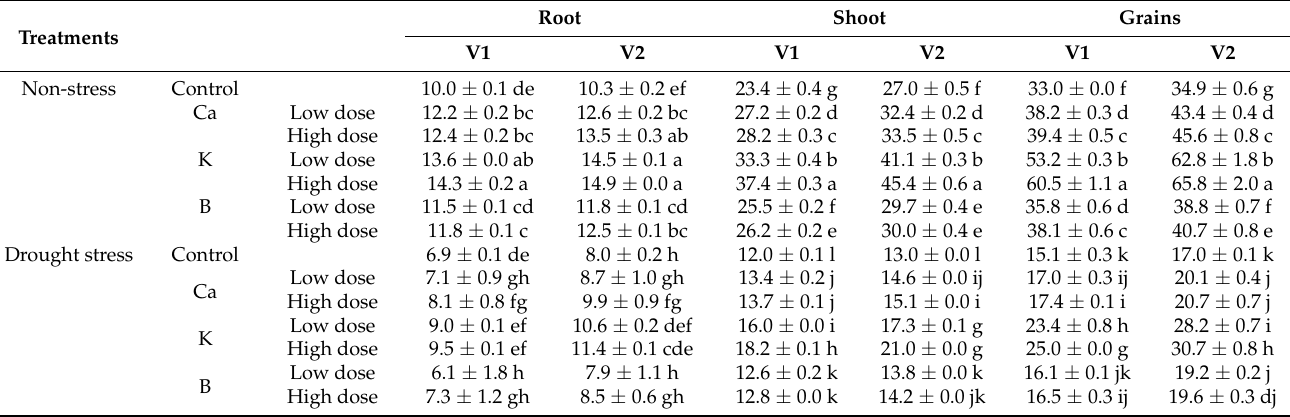
Table 3. Analysis of K content in the root, shoot, and grains of durum wheat. Different letters shows significant difference among the treatments. Standard error was calculated by using the replicates. Shoot Grains